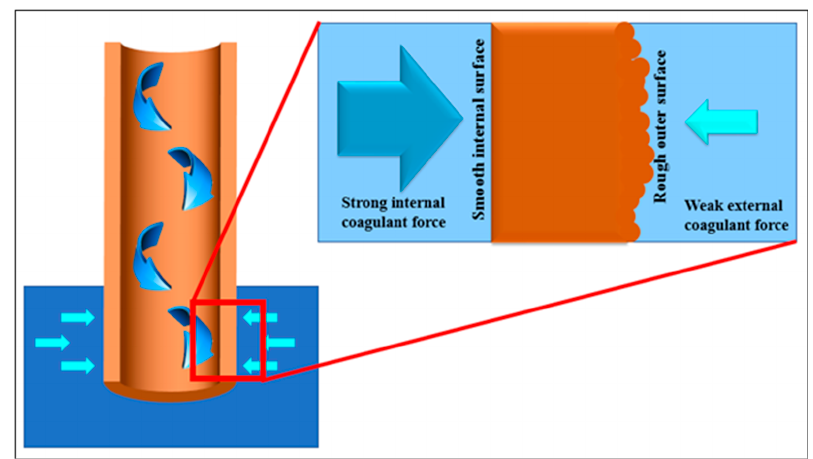
Figure 5. The illustration of the phase inversion process that influences the physical appearance of the inner and outer surfaces of the HFCM.